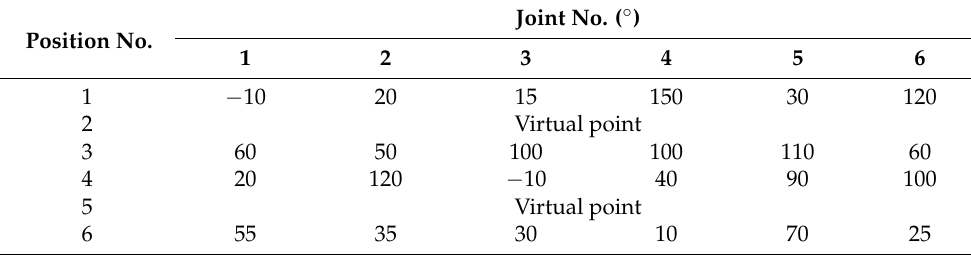
Table 7. Desired positions of the test trajectory planning task.